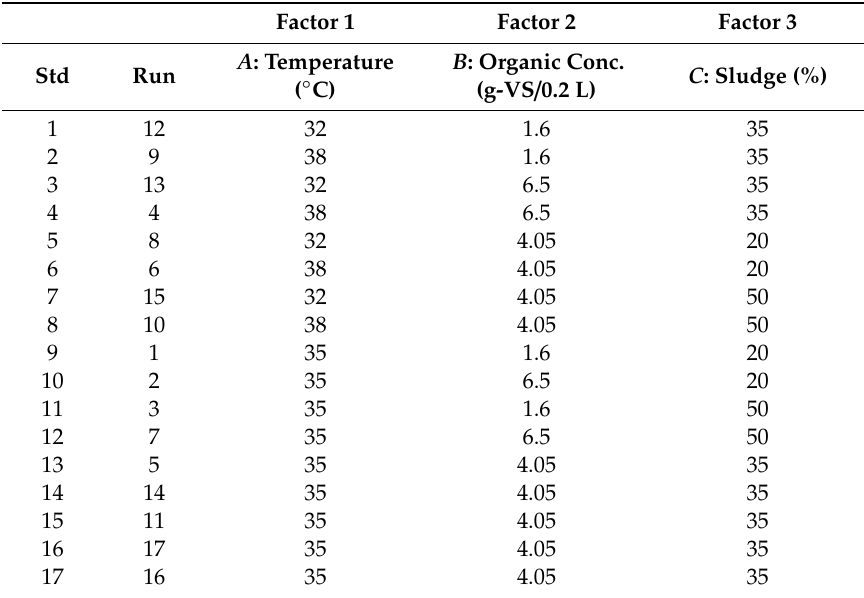
Table 2. The design matrix in actual